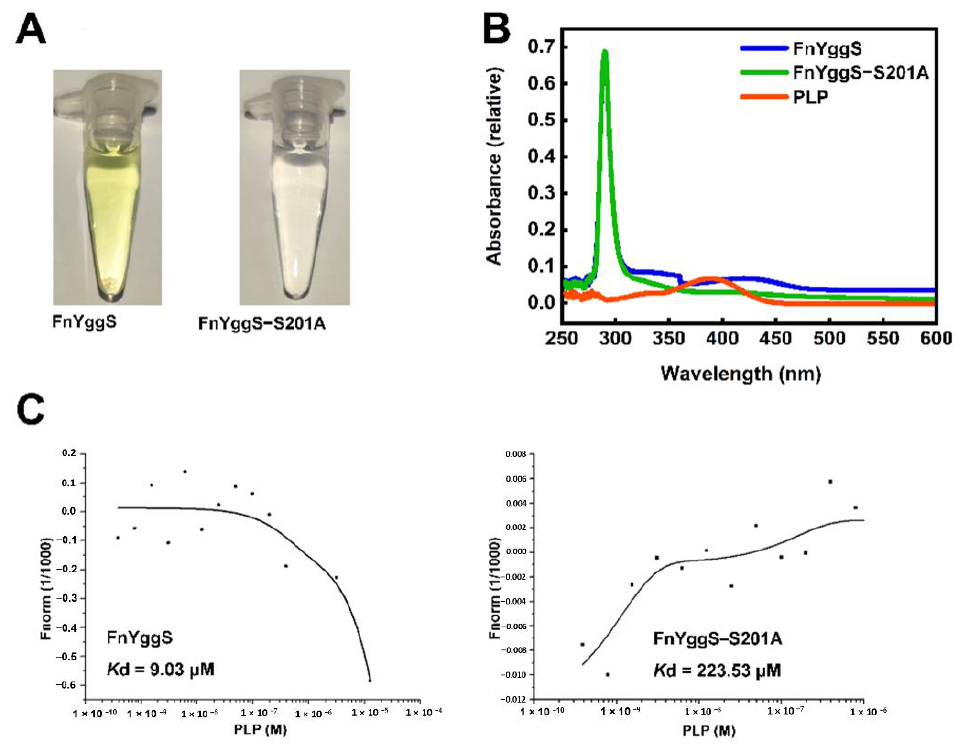
Figure 4. ( A ) Purification and ( B ) spectroscopic analysis of FnYggS (blue) and FnYggS-S201A (green), indicating that Ser201 is critical for PLP binding. ( C ) The binding affinity of FnYggS or FnYggS-S201A and PLP was measured by MST.